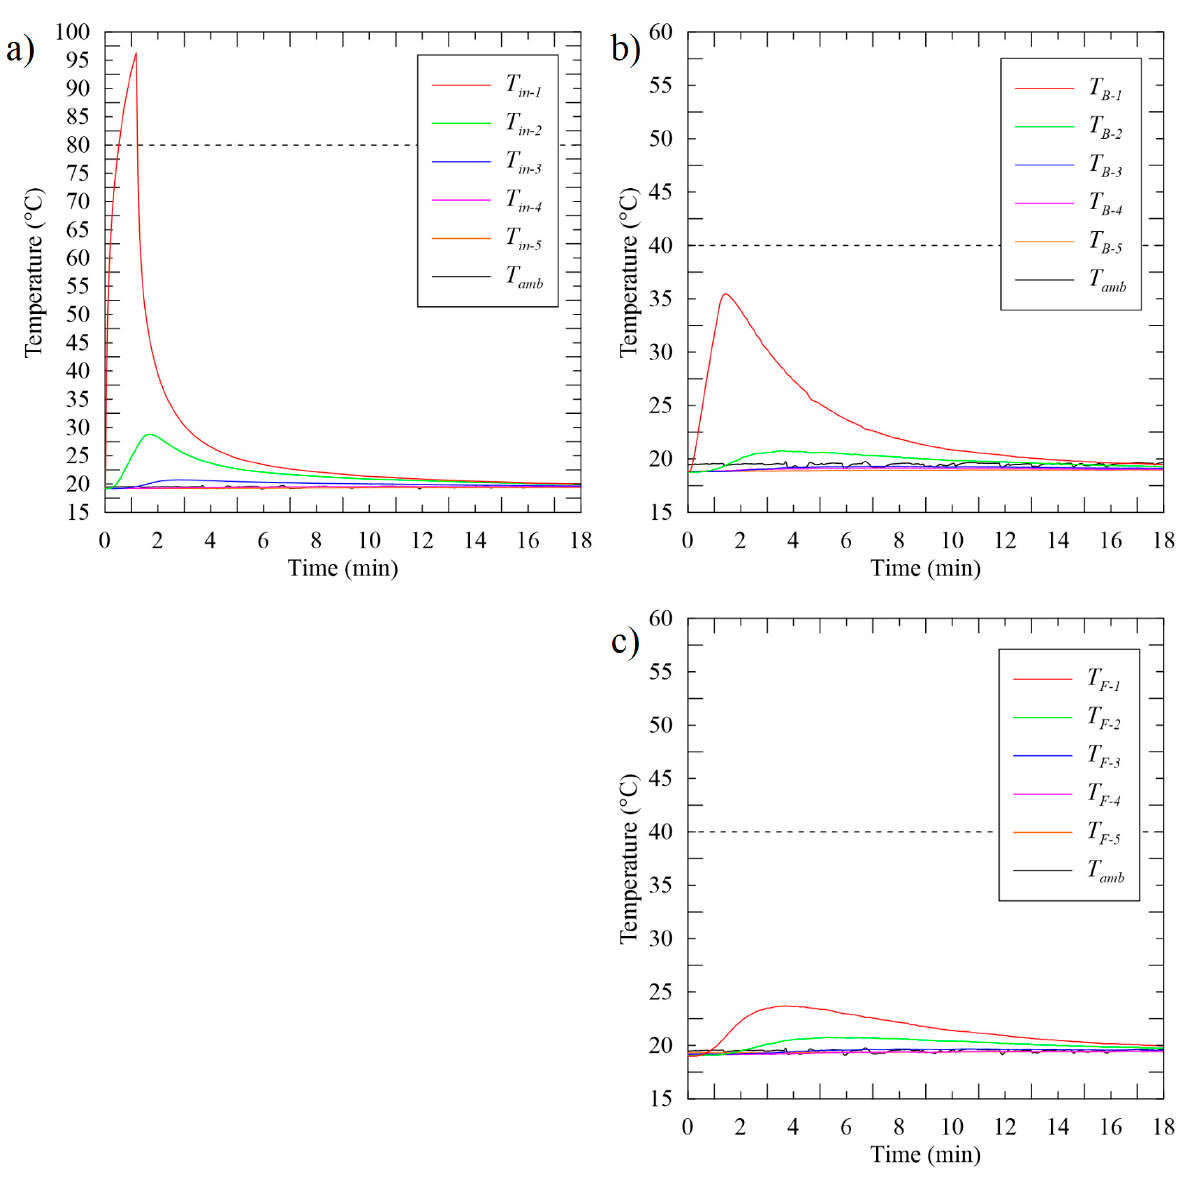
Figure 6. Temperature measurements on the ( a ) inside, ( b ) back cover, and ( c ) display of the mock tablet with no temperature control solution installed and a heat generation rate of 7 W (the dashed line represents the relevant temperature limit).